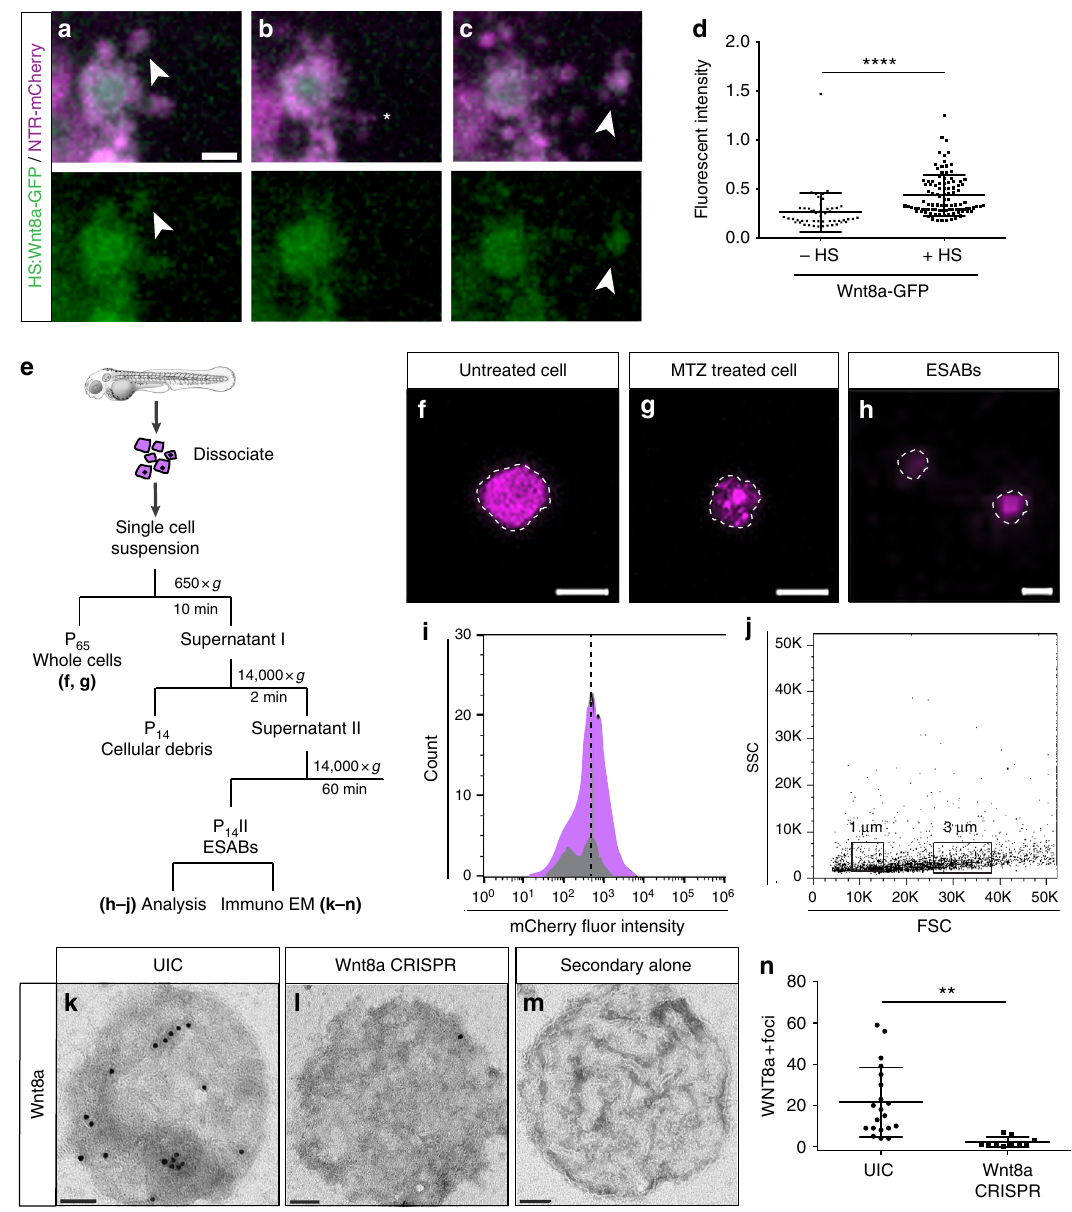
Fig. 5 Apoptosis-induced stem cell division requires Wnt8a on the surface of ESABs (epithelial stem cell-derived apoptotic bodies). a – c Time-lapse confocal images of an epithelial stem cell producing an apoptotic body containing Wnt8a-GFP (scale = 5 µ m), see Supplementary Movie 4. d Quantitation of green fl uorescent protein (GFP) fl uorescence in ESABs after overexpression of Wnt8a by heat-shock induction. e Schematic of strategy to isolate ESABs by differential centrifugation. f – h Whole cells (scale = 10 µ m) and ESABs (scale = 5 µ m) isolated by differential centrifugation exhibit mCherry fl uorescence (magenta) and are appropriate size and morphology. i Quanti fi cation of the number of mCherry-positive ESABs after puri fi cation (magenta), compared to extracellular vesicles isolated from zebra fi sh larvae under homeostatic conditions (gray), using fl ow cytometry. j Size distribution of apoptotic bodies compared to size match bead controls (1 µ m and 3 µ m boxes, FSC = forward scatter, SSC = side scatter, see gating strategy in Supplementary Figure 6 a-b). k – m Transmission electron micrographs of Wnt8a immunogold labeling on whole-mount puri fi ed apoptotic bodies (scale = 500 nm). n The mean number of Wnt8a foci on individual ESABs from uninjected ( n = 21) and Wnt8a CRISPR (clustered regularly interspaced short palindromic repeats)- injected ( n = 10) animals. Data are from three independent experiments and error bars represent sd; **** p < 0.0001, ** p < 0.001. Unpaired two-tailed t -test ( d , n